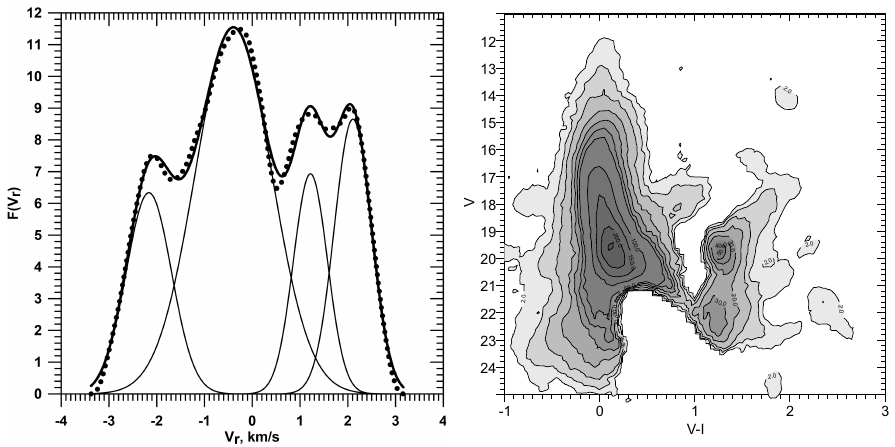
Fig. 4. Left-hand panel : the velocity distribution function of NGC 4337. The dotted line shows the kernel estimate and the thick solid line shows the approximation of the distribution function by the sum of four Gaussian curves (the thin solid lines). Right- hand panel : the difference between the Hess diagrams of the NGC 2100 cluster field and the control